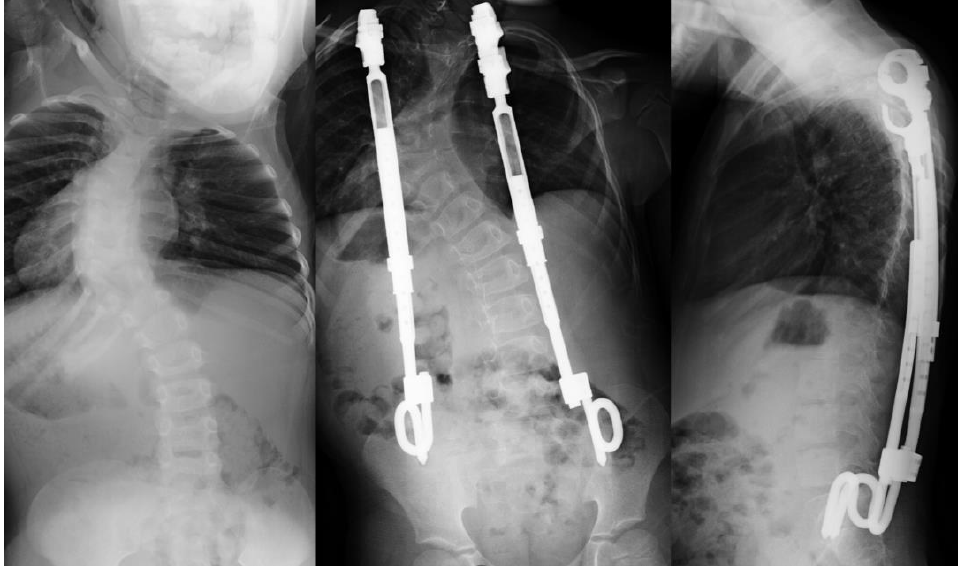
Figure 4. Left: preoperative of large magnitude scoliosis, Center: postoperative anterior-posterior radiograph, Right: lateral radiographs following the application of two VEPTR rods.